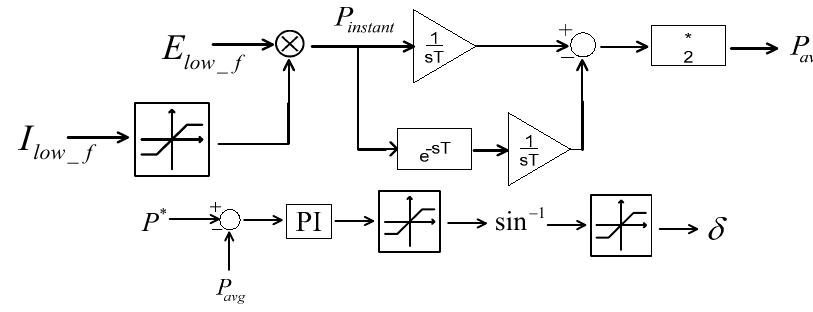
Figure 10. Control scheme of transmitting power control.